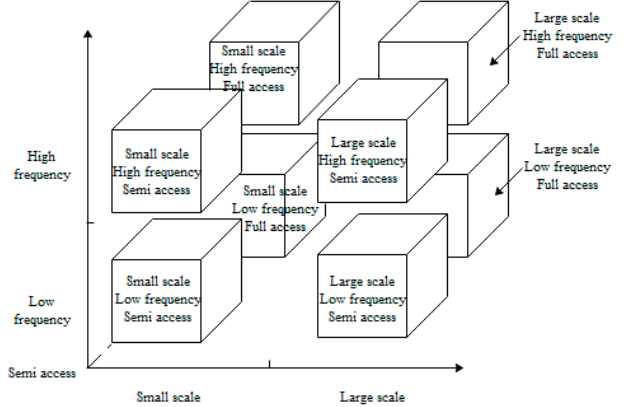
Figure 2. Types of public space. Table 3. The distribution of public space in nine